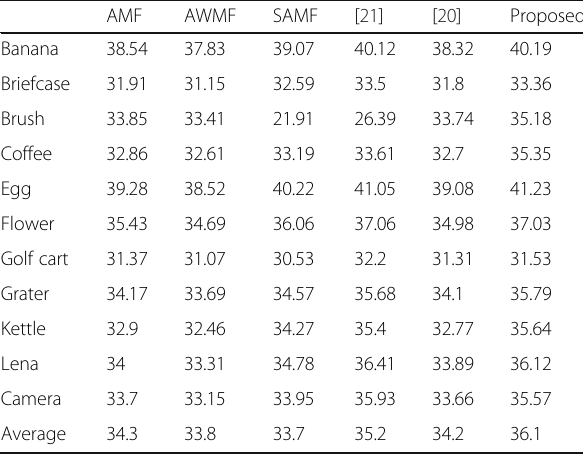
Table 4 PSNR comparison for 30% noise (dB)